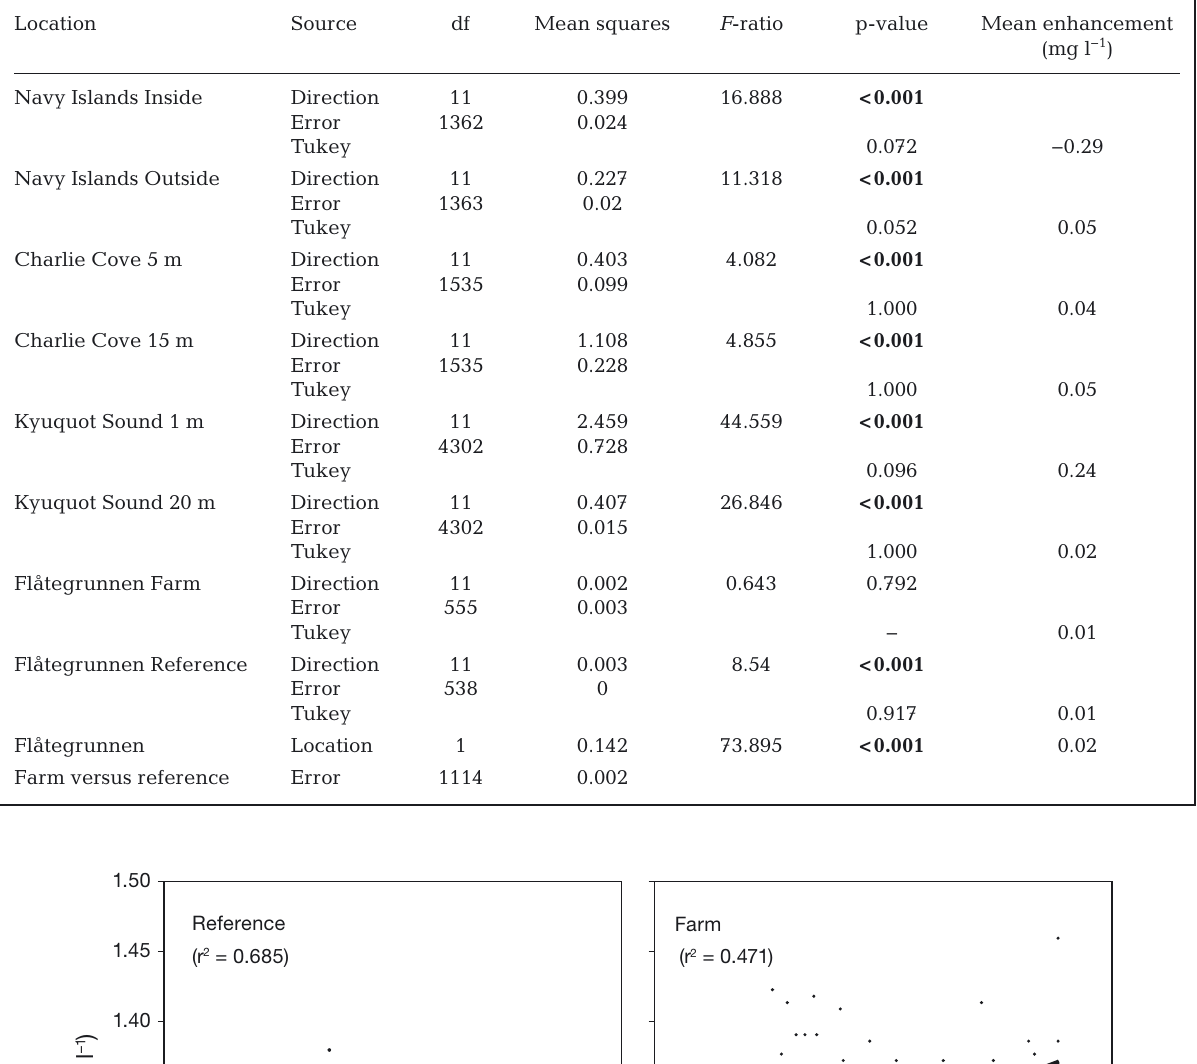
Table 3. Summary of ANOVA results comparing mean suspended particulate matter concentrations with current direction (12 direction levels representing 30 degree increments) or between farm and reference locations (Flåtegrunnen farm only). Signif- icant ANOVA results (in bold ) for the direction comparisons were followed by a single Tukey post hoc test comparing mean suspended particulate matter (SPM) values in the 2 direction bins that represent water flowing directly towards and away from the closest net-pen. The mean SPM enhancement at the mooring site was calculated from these 2 mean values